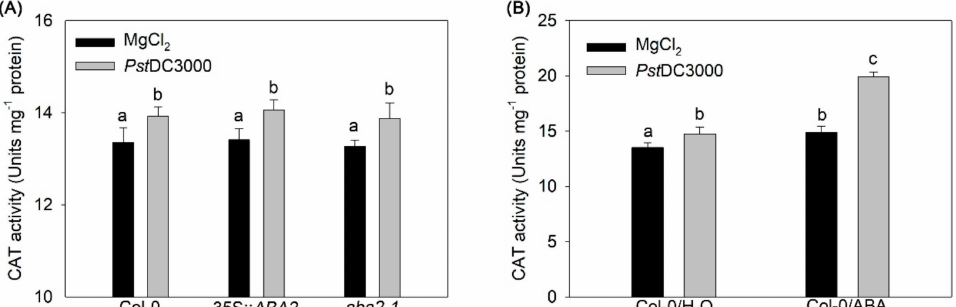
Figure 3. E ff ects of endogenous and exogenous abscisic acid (ABA) on catalase (CAT) activity under Pst DC3000 infection in Arabidopsis ( A ) Endogenous ABA and ( B ) exogenous ABA. For analyzing exogenous ABA, wild-type (Col-0) plants were treated with distilled water (H 2 O) or ABA before inoculation with Pst DC3000. Error bars indicate the standard error, and values were based on at least three independent replicates. Di ff erent letters indicate values that are significantly di ff erent ( p <